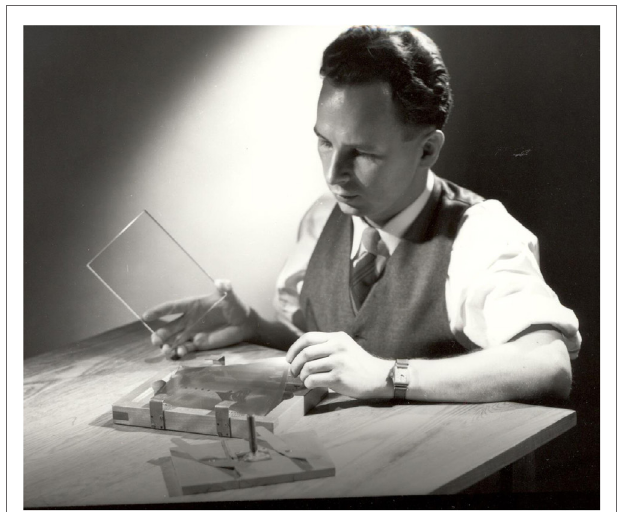
FiGURe 2 | Don Stookey at work on photosensitive gold ruby glass .